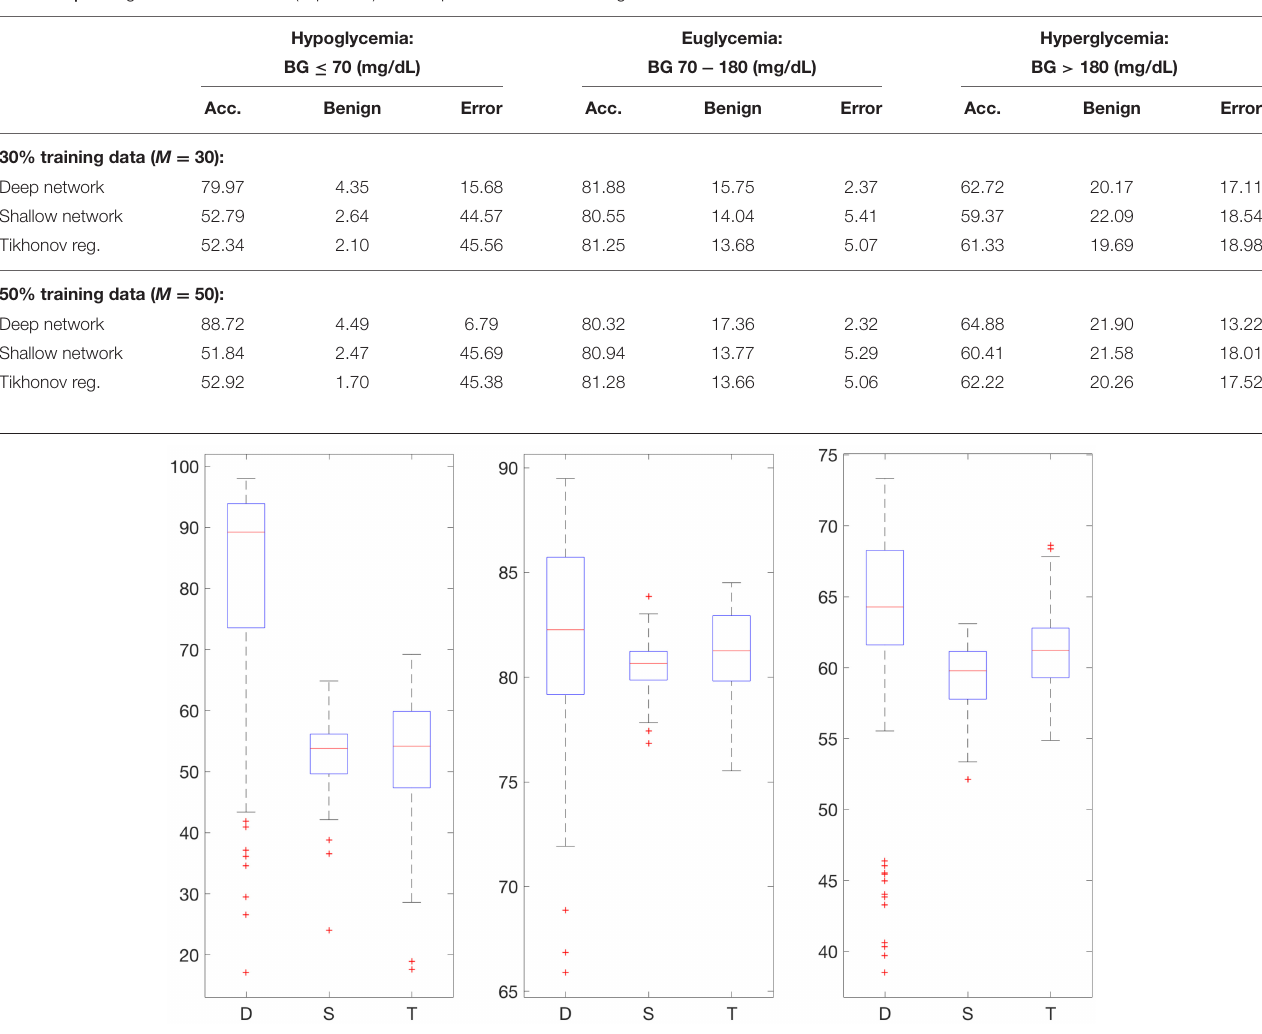
TABLE 1 | Average PRED-EGA scores (in percent): M % of patients used for training. Hypoglycemia: Euglycemia: